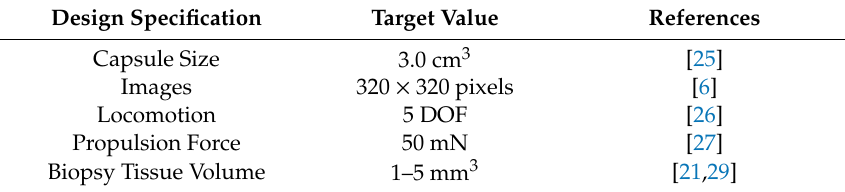
Table 1. Design specifications of a biopsy capsule endoscope